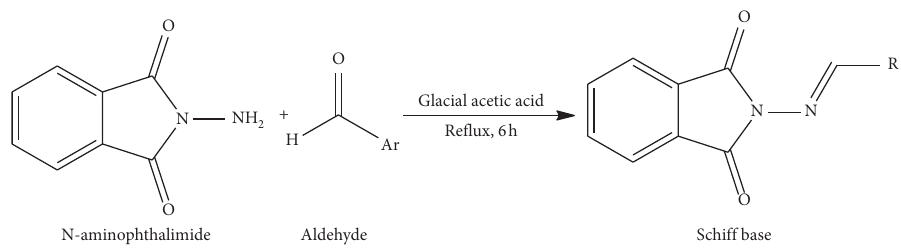
Figure 1: General synthesis route for N-aminophthalimide derivatives.